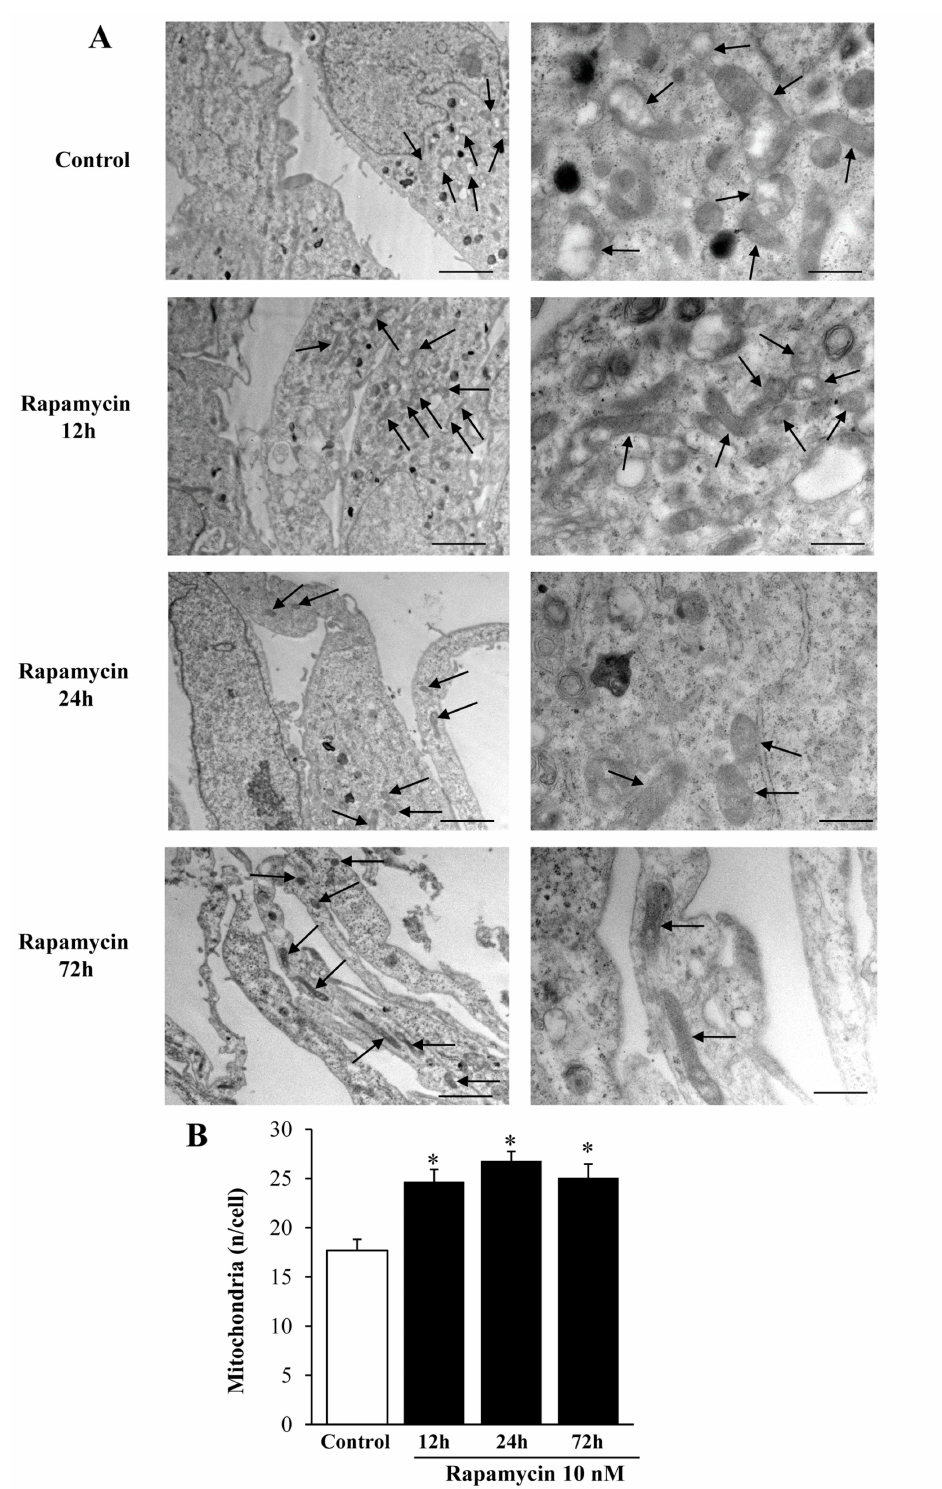
Figure 4. Rapamycin time-dependently increases mitochondrial number in A172 cell line. ( A ) Representative TEM micrographs showing mitochondria (indicated by black arrows) from Control and from di ff erent time of continuous rapamycin 10 nM exposure. ( B ) Graph reports the number of mitochondria per cell. Values are the mean ± S.E.M. from 30 cells per group. ∗ p ≤ 0.05 vs. Control. Scale bars = 1 µ m (low magnification) and 0.45 µ m (high